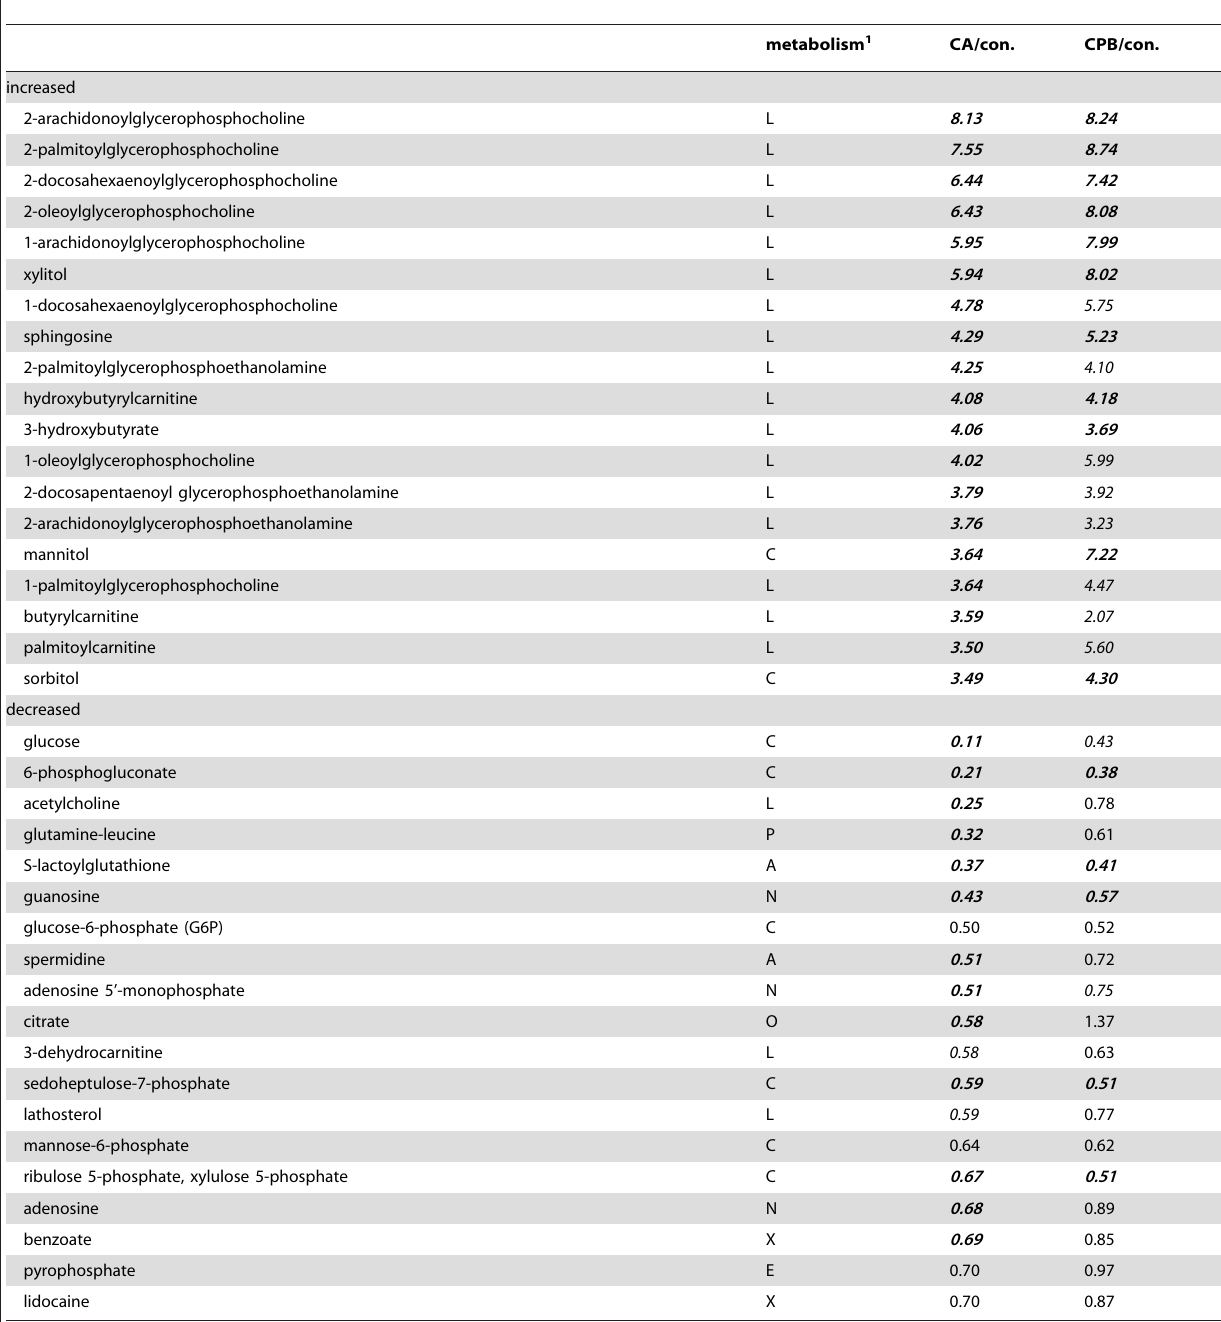
Table 4. Metabolic changes in brain tissue (n =5; bolditalic , p , 0.05; italic , 0.05 , p , 0.1).